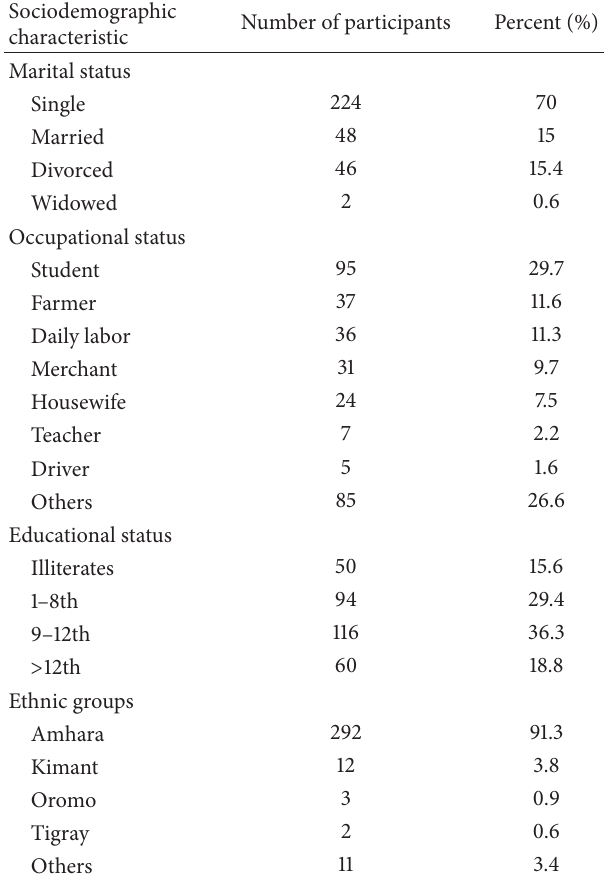
Table 1: Sociodemographic characteristics of HIV1/2